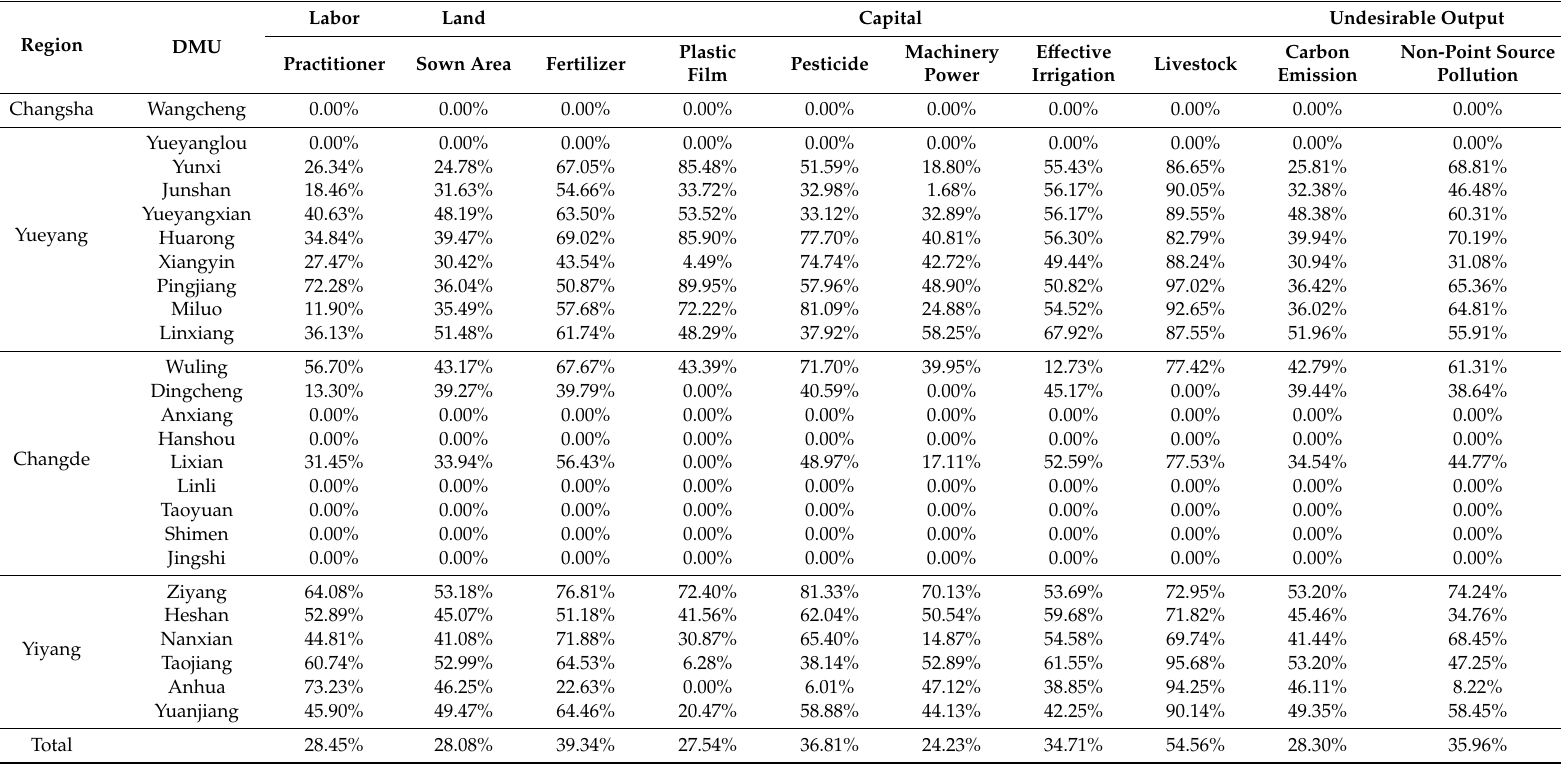
Table 7. Redundancy of inputs and outputs of cultivated land use e ffi ciency in